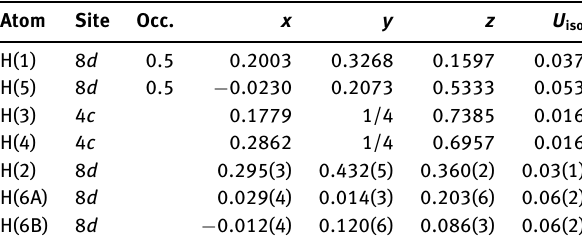
Table 2: Atomic coordinates and displacement parameters (in Å 2